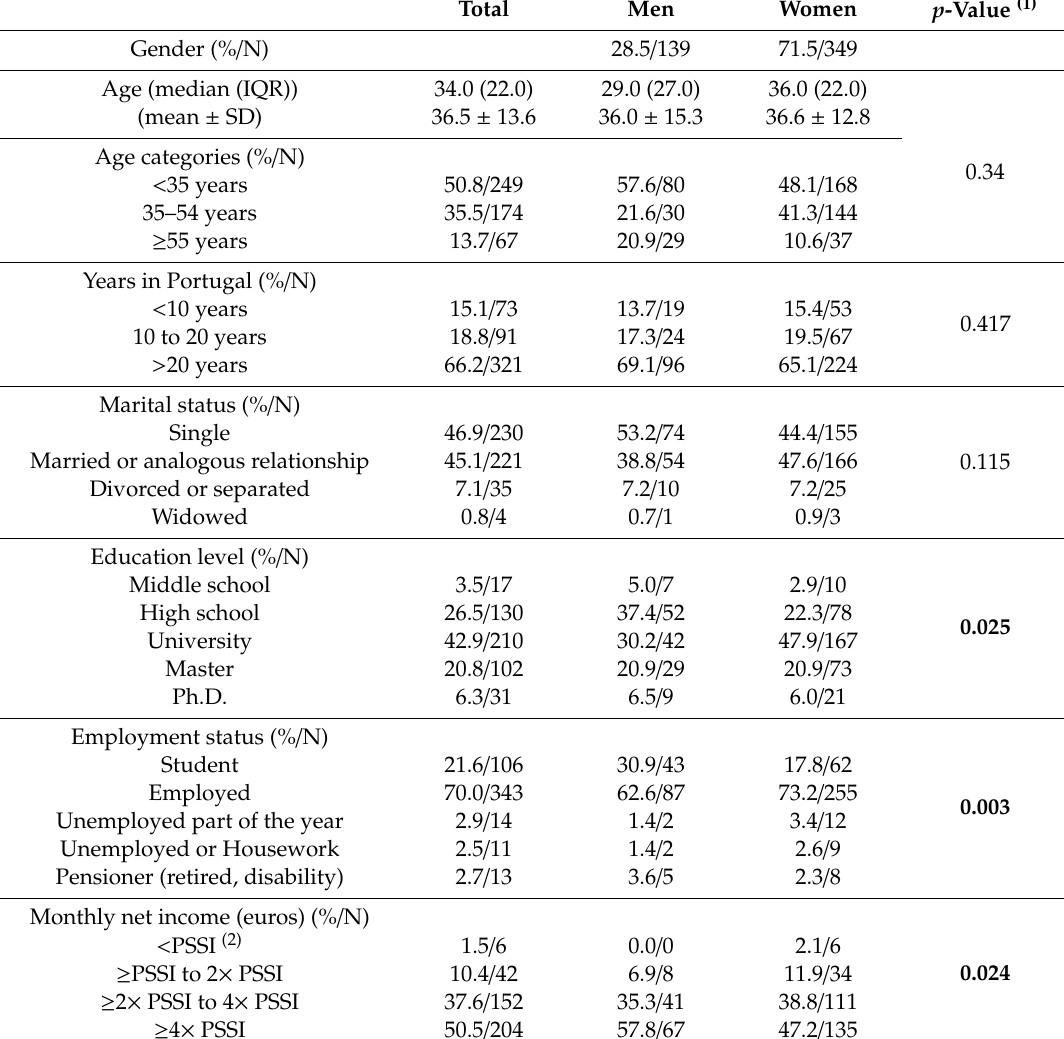
Table 1. Participants’ sociodemographic characteristics and gender